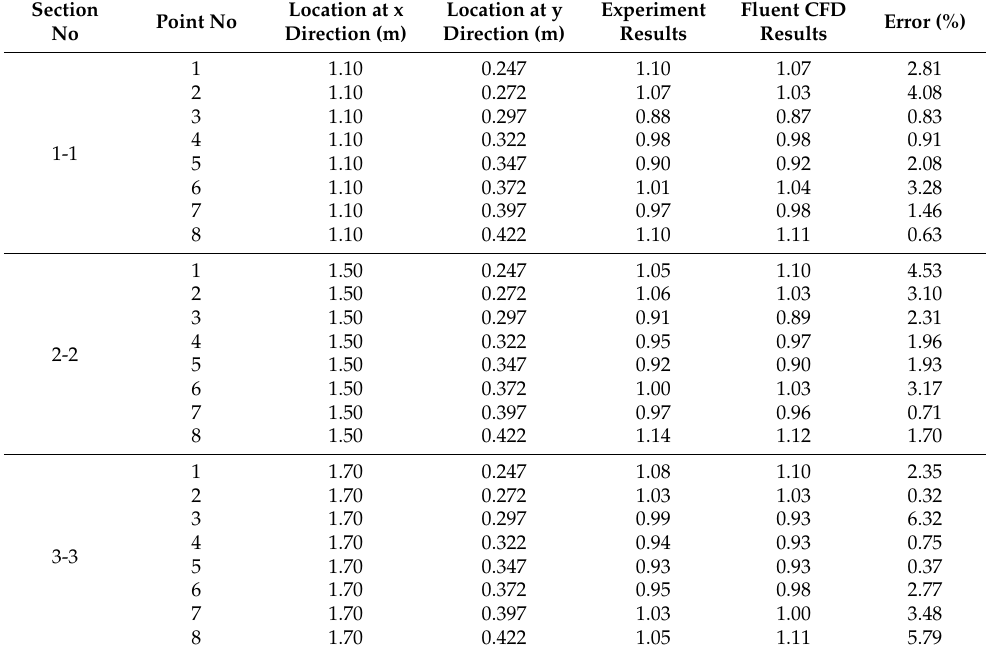
Table 5. CFD and experimental velocity results for with vane situation at Sections 1-1, 2-2 and 3-3. Section Location at x Location at y Experiment Fluent CFD Point No No Direction (m) Direction (m) Results